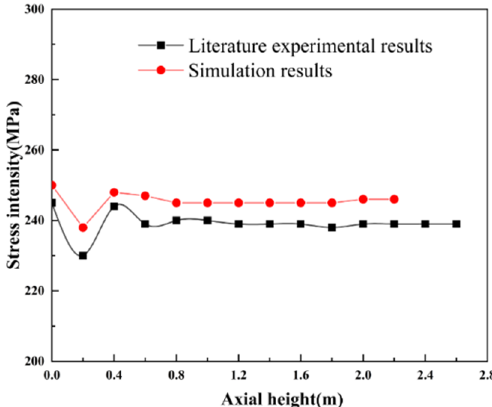
Figure 5. Model verification of stress intensity distribution along the axial height.